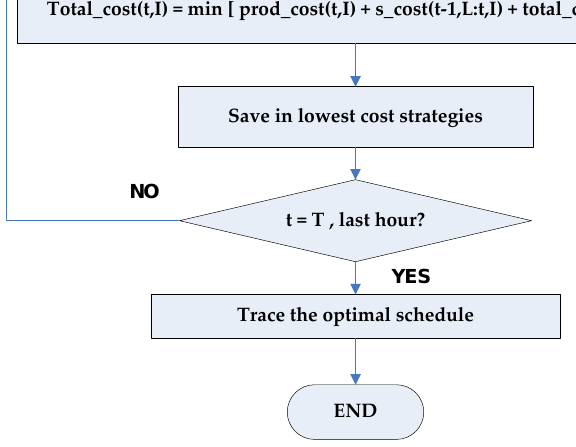
Figure 1. A flowchart for the forward dynamic programming algorithm.